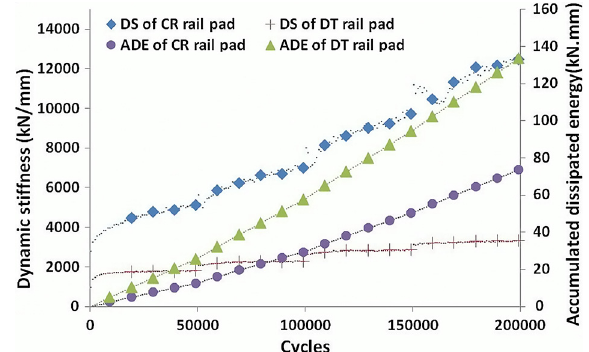
Fig. 6. Dynamic stiffness (DS) and dissipated energy (DE) for DT and CR rail pads